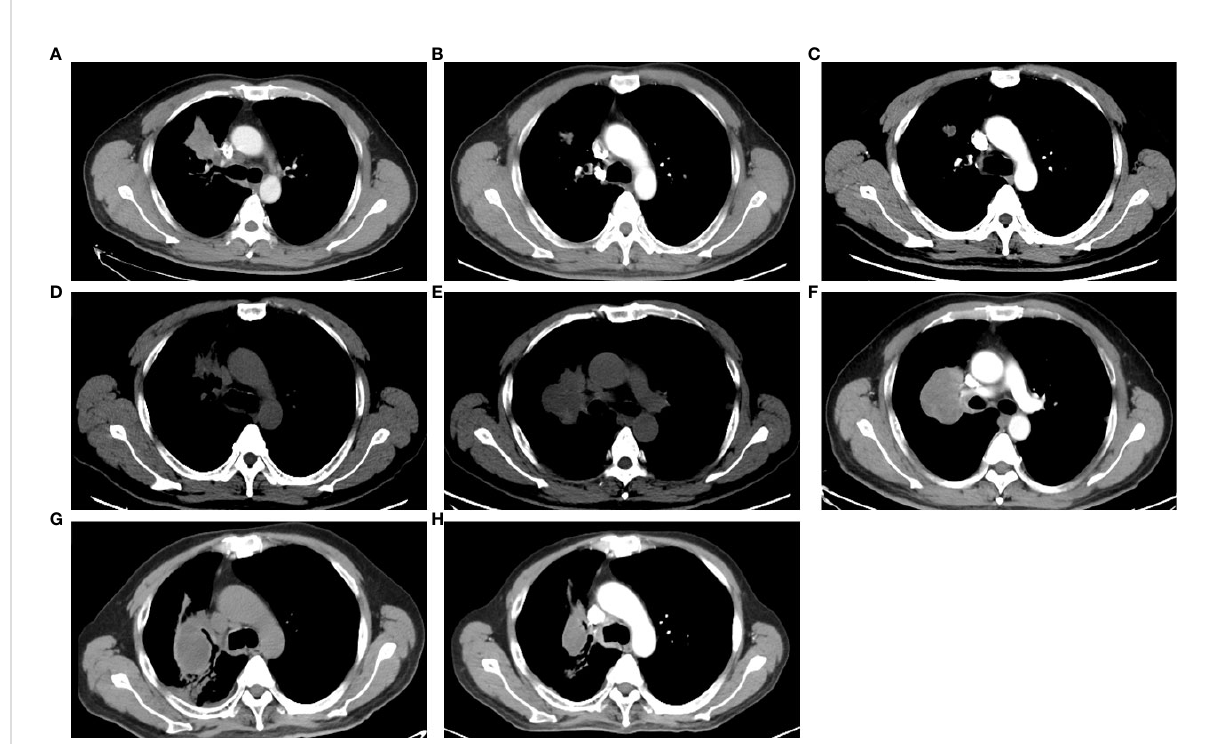
FIGURE 2 The images of CT scans with different treatments. (A) CT scan of basic examination before fi rst-line erlotinib. (B) CT scan during the fi rst-line erlotinib treatment. (C) CT scan at the progression of fi rst-line erlotinib. (D) CT scan at progression of second-line osimertinib. (E) CT scan at the progression of chemotherapy. (F) CT scan at progression of afatinib plus nimotuzumab. (G) CT scan at the progression of immunotherapy. (H) CT scan during combination therapy of irinotecan, nimotuzumab, and